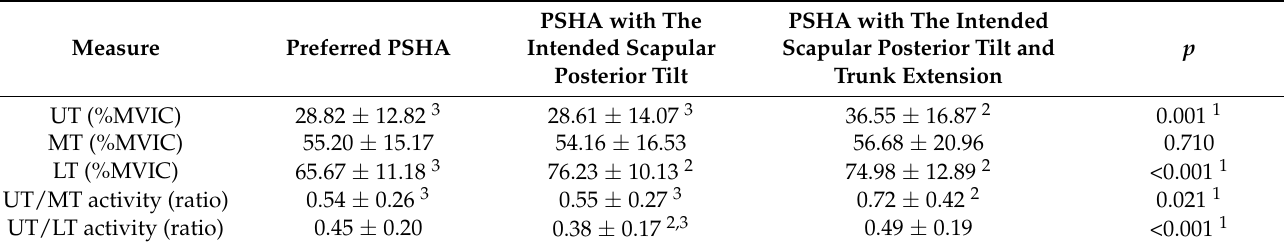
Table 2. Muscle activity during